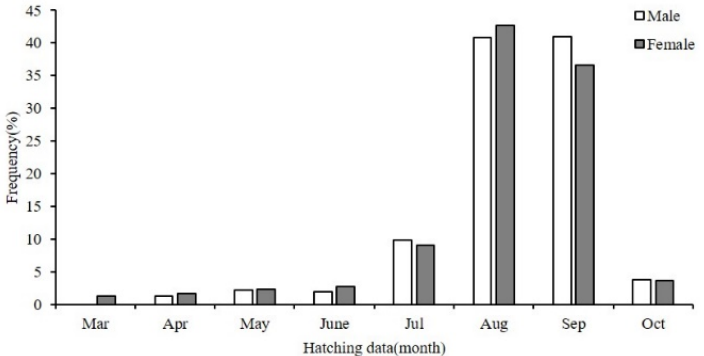
Figure 6. Hatching date frequency distribution of B. magister shevtsovi by sex.